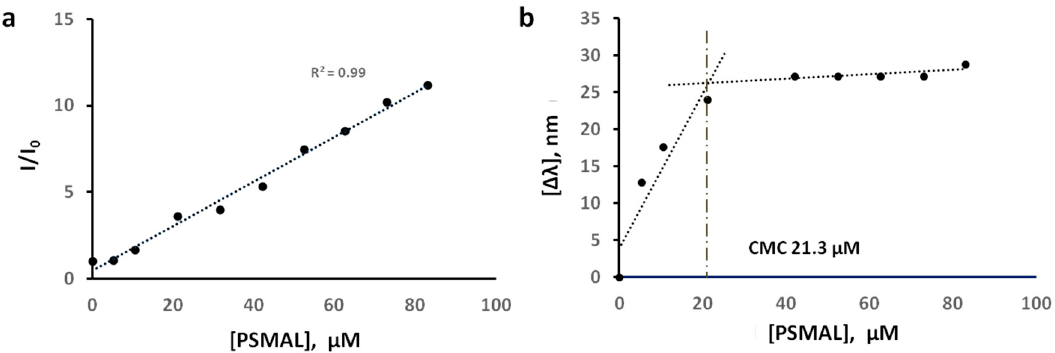
Figure 6. ( a ) Relative fluorescence intensity of N -phenyl-1-naphthylamine (NPN) in presence of varying concentrations of P 3 . ( b ) Shift in the emission maxima of NPN with respect to P 3 concentration ( λ ex = 340 nm).